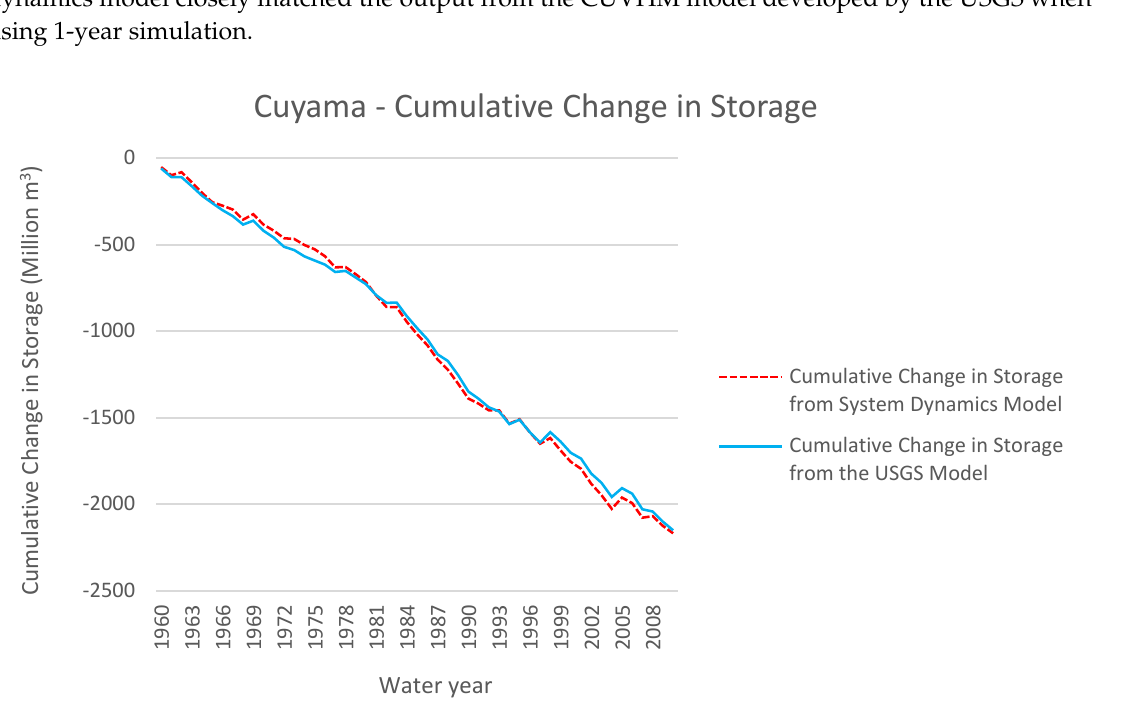
Table 6. Comparison of results for the 1-year simulation.